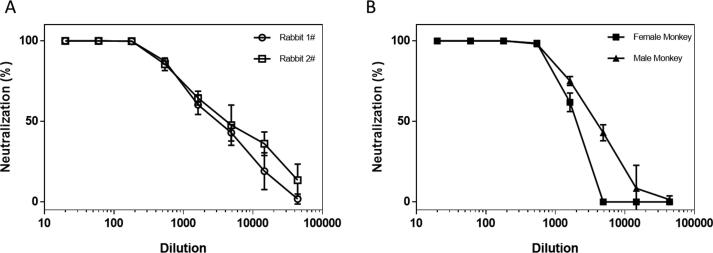
Pseudo-Virus neutralizing activities of antisera from S1-Fc-immunized rabbits and monkeys. A) The neutralizing activity of rabbit sera was evaluated with SARS-CoV-2 pseudo-virus. The horizontal coordinate is serum dilution and the vertical coordinate is the percentage of the neutralization. B) The neutralizing activity of macaque sera was evaluated with SARS-CoV-2 pseudo-virus. The horizontal coordinate is serum dilution and the vertical coordinate is the percentage of the neutralization.